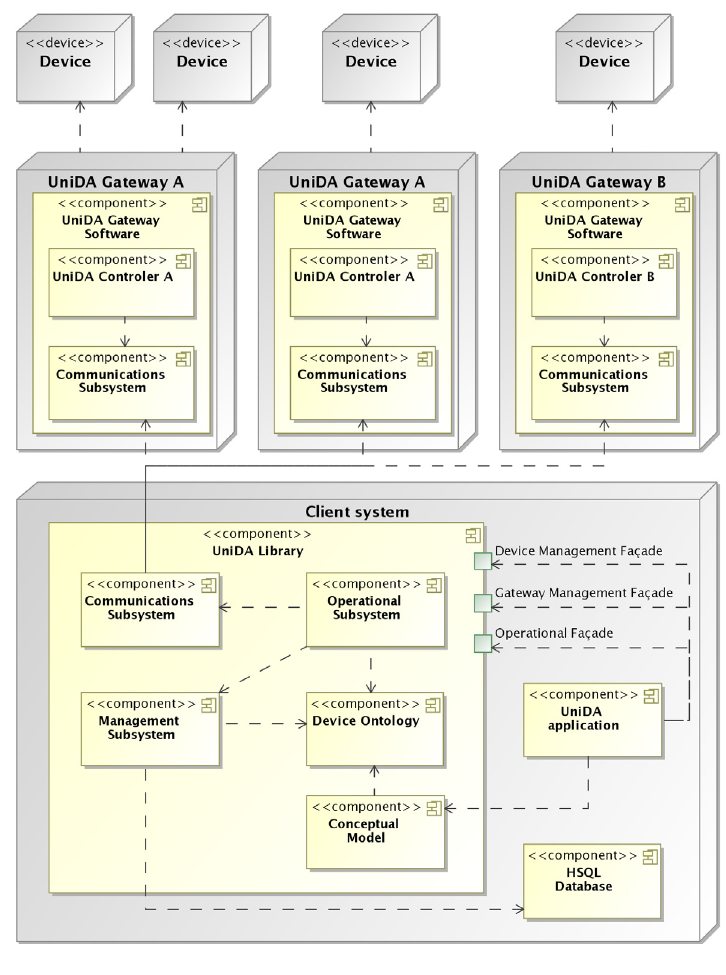
Figure 3. Architecture diagram of an UniDA